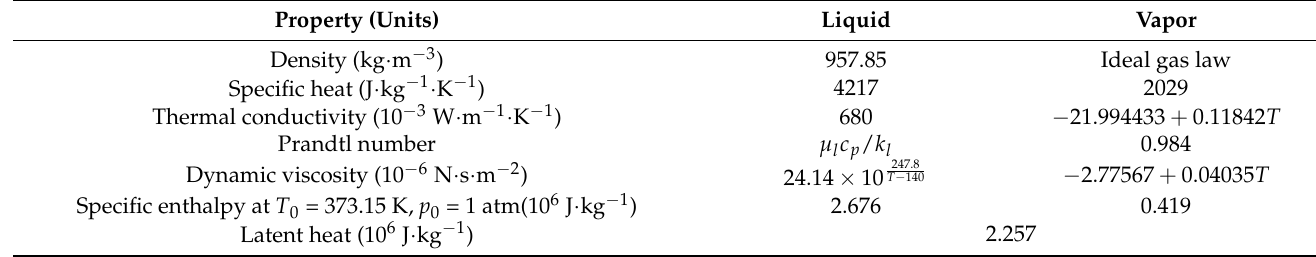
Table 2. Thermal properties of water (Xin